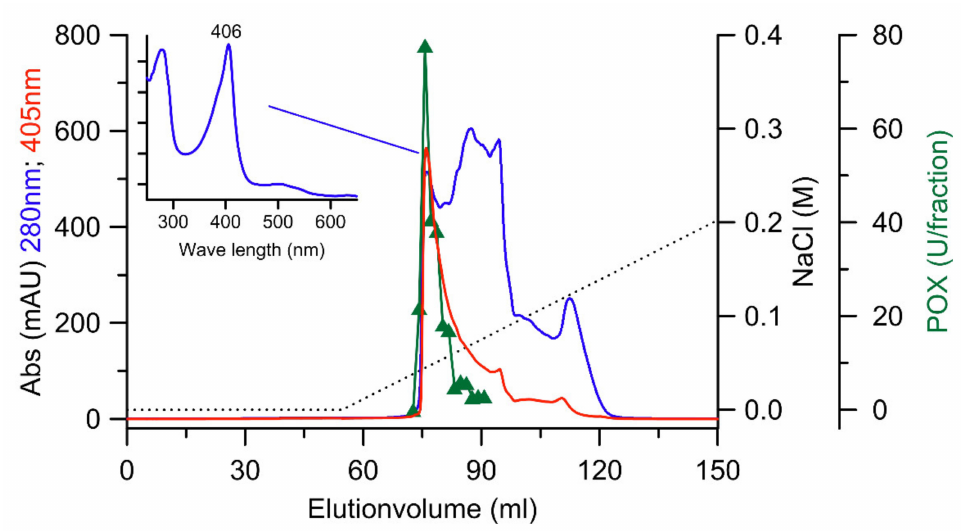
Figure 2. FPLC elution profiles of the last re-chromatographic purification step of Xgr DyP using a MonoQ column (10 × 100 mm). Absorption (mAU) at 280 nm (blue → total protein) and 405 nm (red → heme), DyP activity (green), NaCl gradient (dashed line).